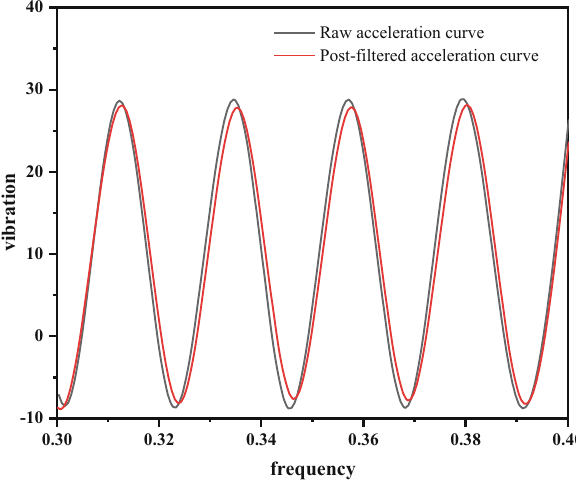
The acceleration data are integrated twice; the displace - ment of the vibration can be obtained. The proposed method is mainly to detect the vibration of fi xed equip - ment, the curve trajectory drawn by the acceleration data collected by the system. Similar to the reciprocating motion of a sine wave, it can also be seen from the fi ltered curves in Figures 4 and 5 that the acceleration curve is